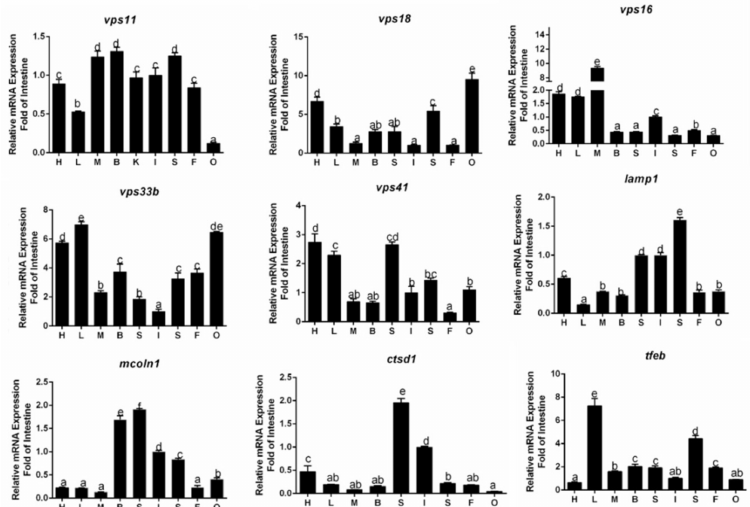
Figure 1. Real-time quantitative polymerase chain reaction (qPCR) analysis for tissue distribution of gene expression across the heart (H), liver (L), muscle (M), spleen (S), brain (B), mesenteric fat (F), intestine (I), kidney (K) and ovary (O) of P. fulvidraco . Bars that share di ff erent letters indicate significant di ff erences among the tissues ( p < 0.05).